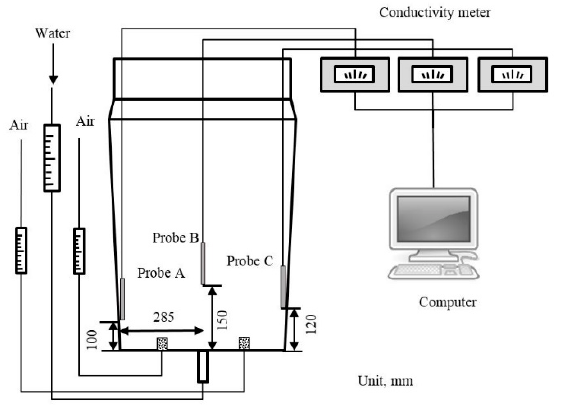
Figure 2. Schematic of the mixing time measurement system.